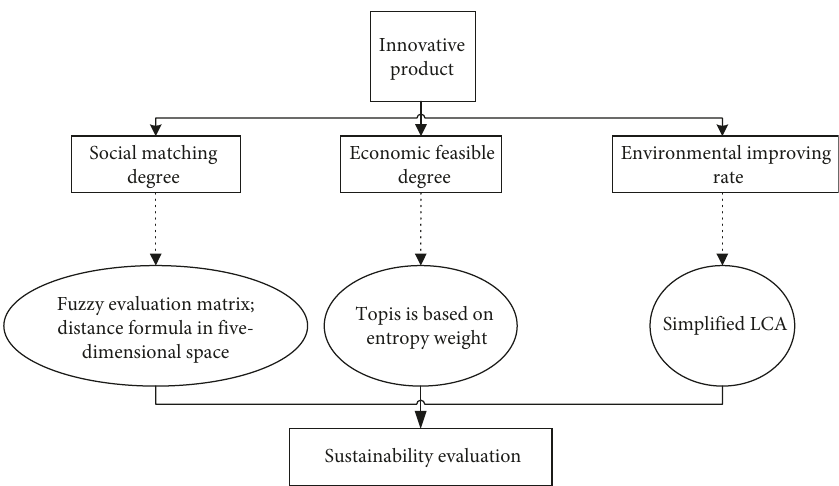
Figure 2: The framework for evaluating the sustainability of innovative products. Table 1: The evaluation table of social matching degree.